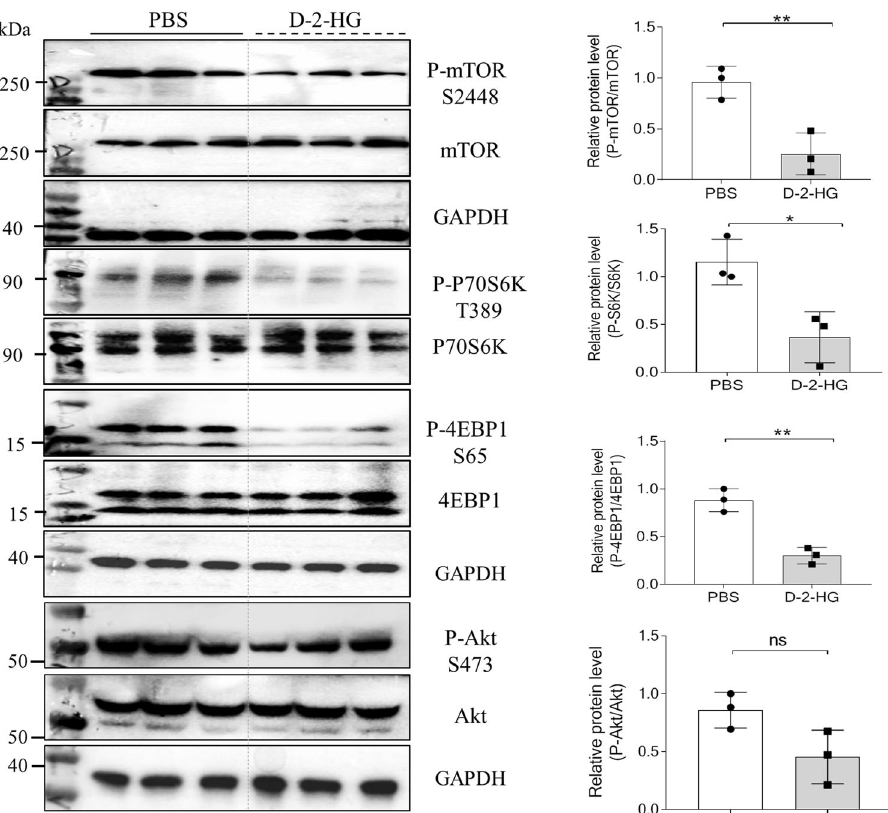
Fig. 6 D-2-HG suppressed the mTOR signaling. At 4 h after PBS or 5 mM D-2-HG exposure, the proteins of the EpCAM + cells were extracted for western blotting (WB). Representative WB analysis for the key proteins in the mTOR signaling, including mTOR, p70 S6K, 4EBP1, and AKT. Quanti fi cation for the expression of key proteins in the mTOR signaling. ns, not signi fi cant, * P < 0.05, ** P <